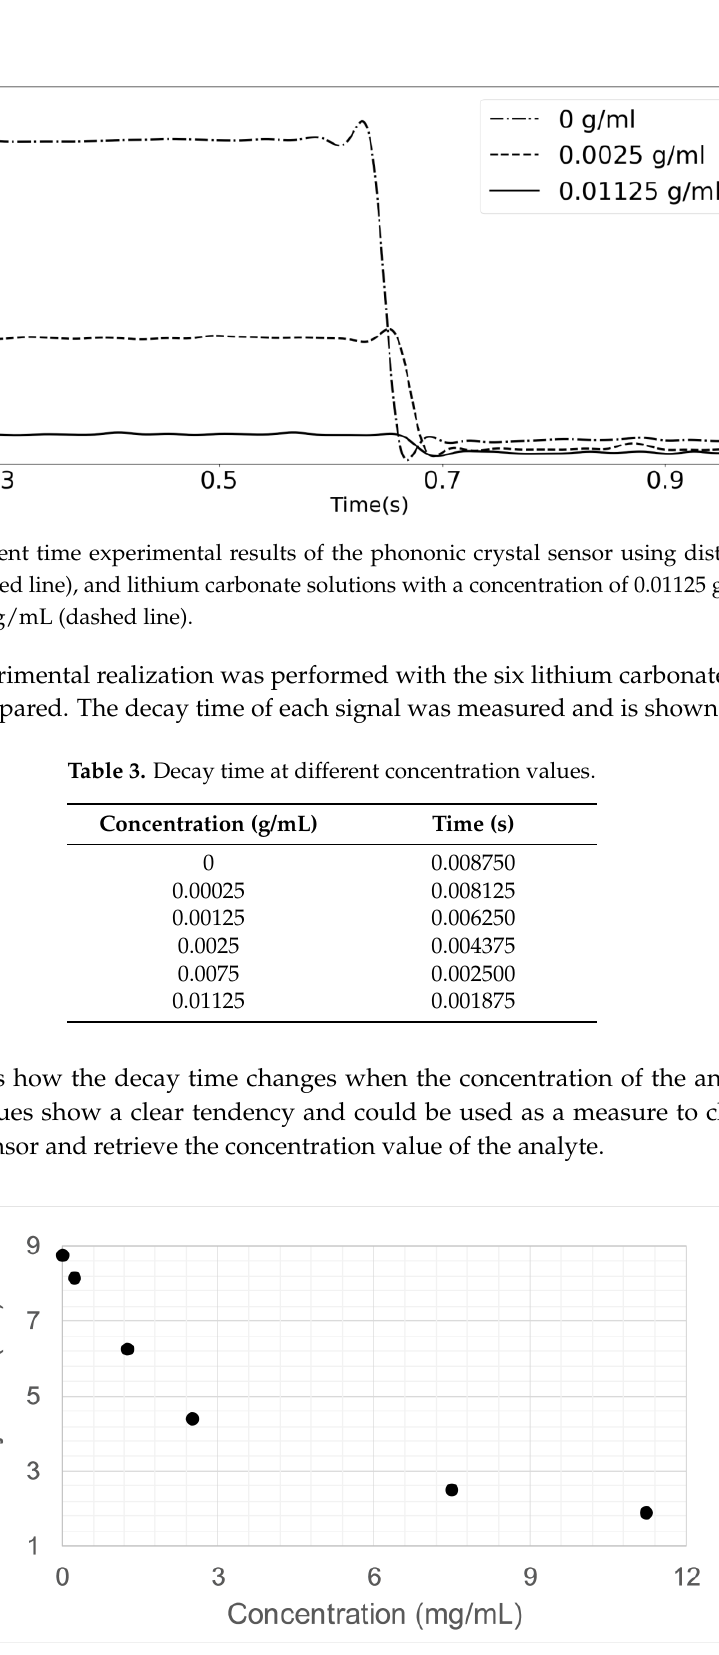
Figure 7. Relationship between the concentration of the lithium carbonate solution used as the analyte and the decay time obtained.